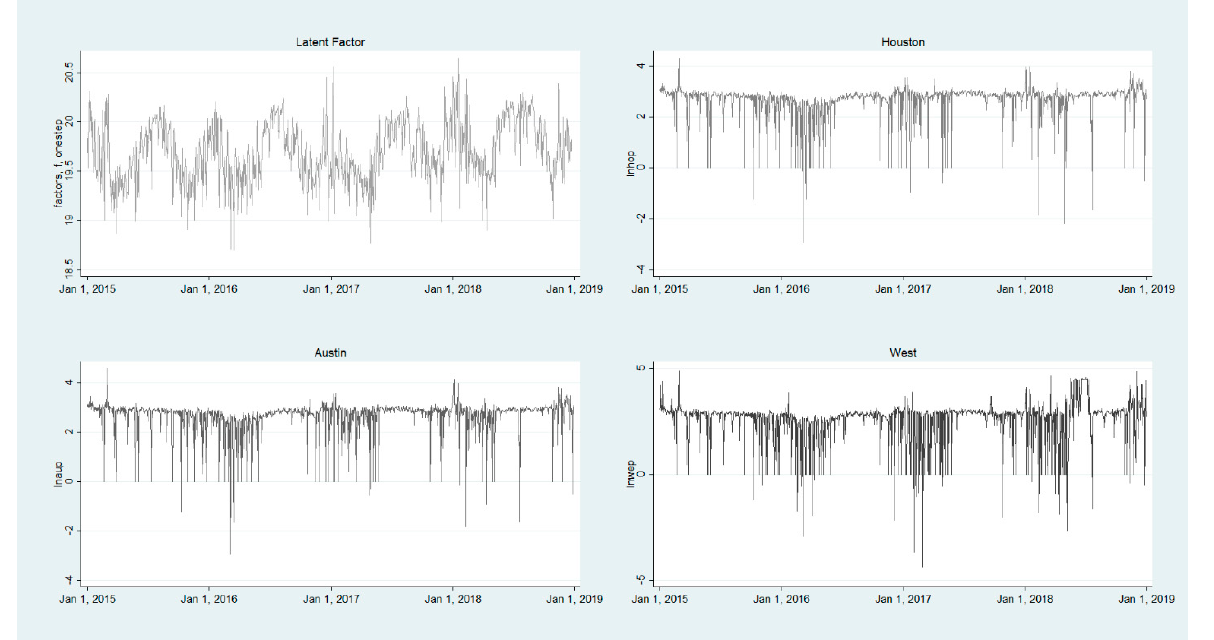
Figure 4. 4:00 a.m.—Latent Factor and Houston series (top left and right); Austin and West (Bottom left and right).